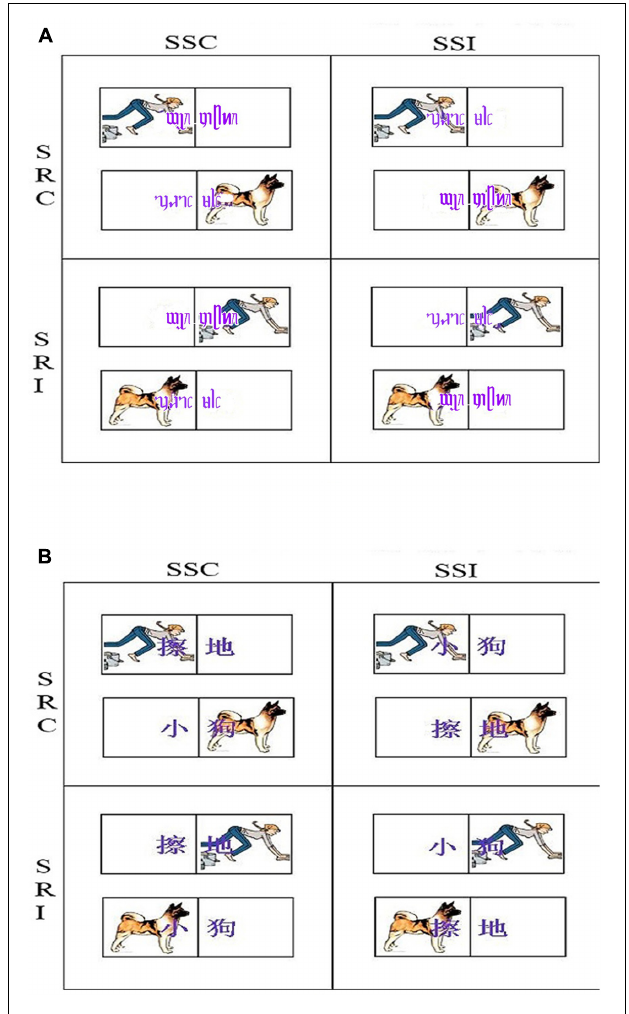
FIGURE 1 | Stimulus–stimulus and stimulus–response compatibility paradigm example. The figure above shows the relational positions of the pictures and key presses. The instructions were as follows: when a nominal picture is shown, press the “L” key; when a verbal picture is shown, press the “A” key. Response keys were counterbalanced, such that another group had nominal pictures assigned to the “A” key, and verbal pictures assigned to the “L.” SSC, stimulus–stimulus consistent; SSI, stimulus–stimulus inconsistent; SRC, stimulus–response consistent; and SRI, stimulus–response inconsistent.